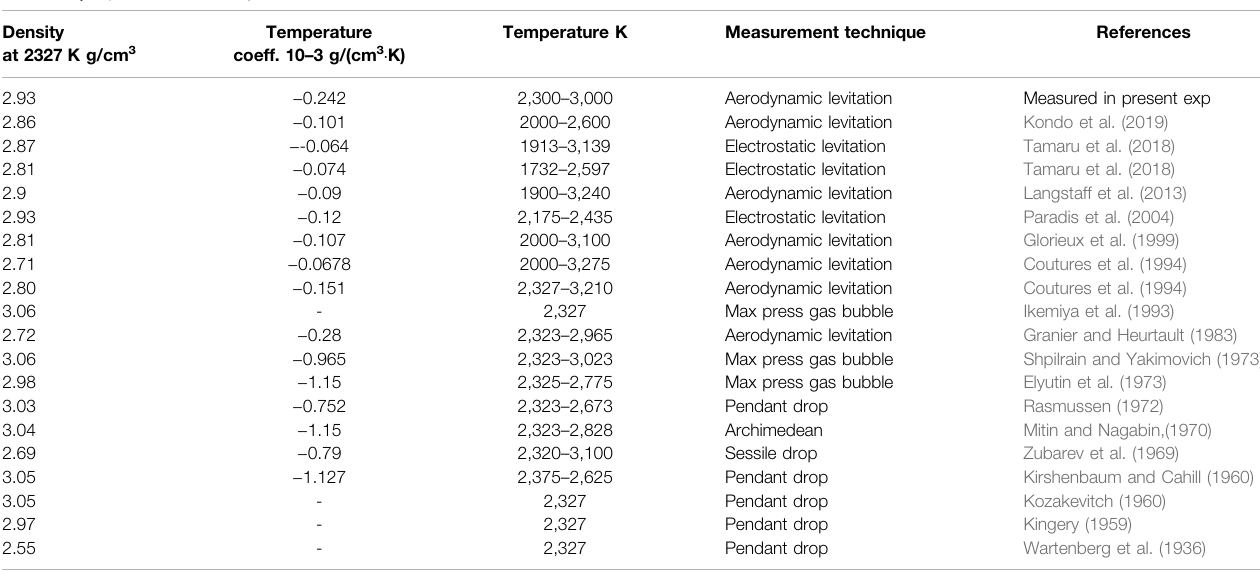
TABLE 2 | Liquid alumina density in literatures.